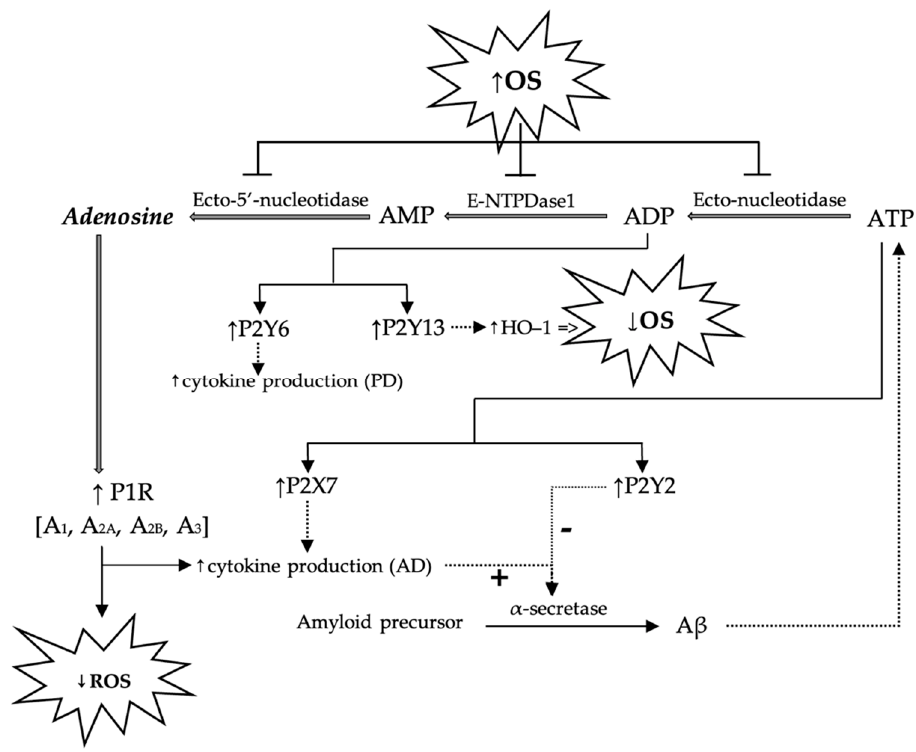
Figure 3. Schematic presentation of possible mechanisms by which adenosine and purine nucleotides (AMP, ADP, ATP) modulate ROS generation and possible implications in the pathogenesis of Alzheimer’s and Parkinson’s diseases. P1R—purinergic receptor 1; OS—oxidative stress; ROS—reactive oxygen species; A β —beta-amyloid; AD—Alzheimer’s disease; PD—Parkinson’s disease.